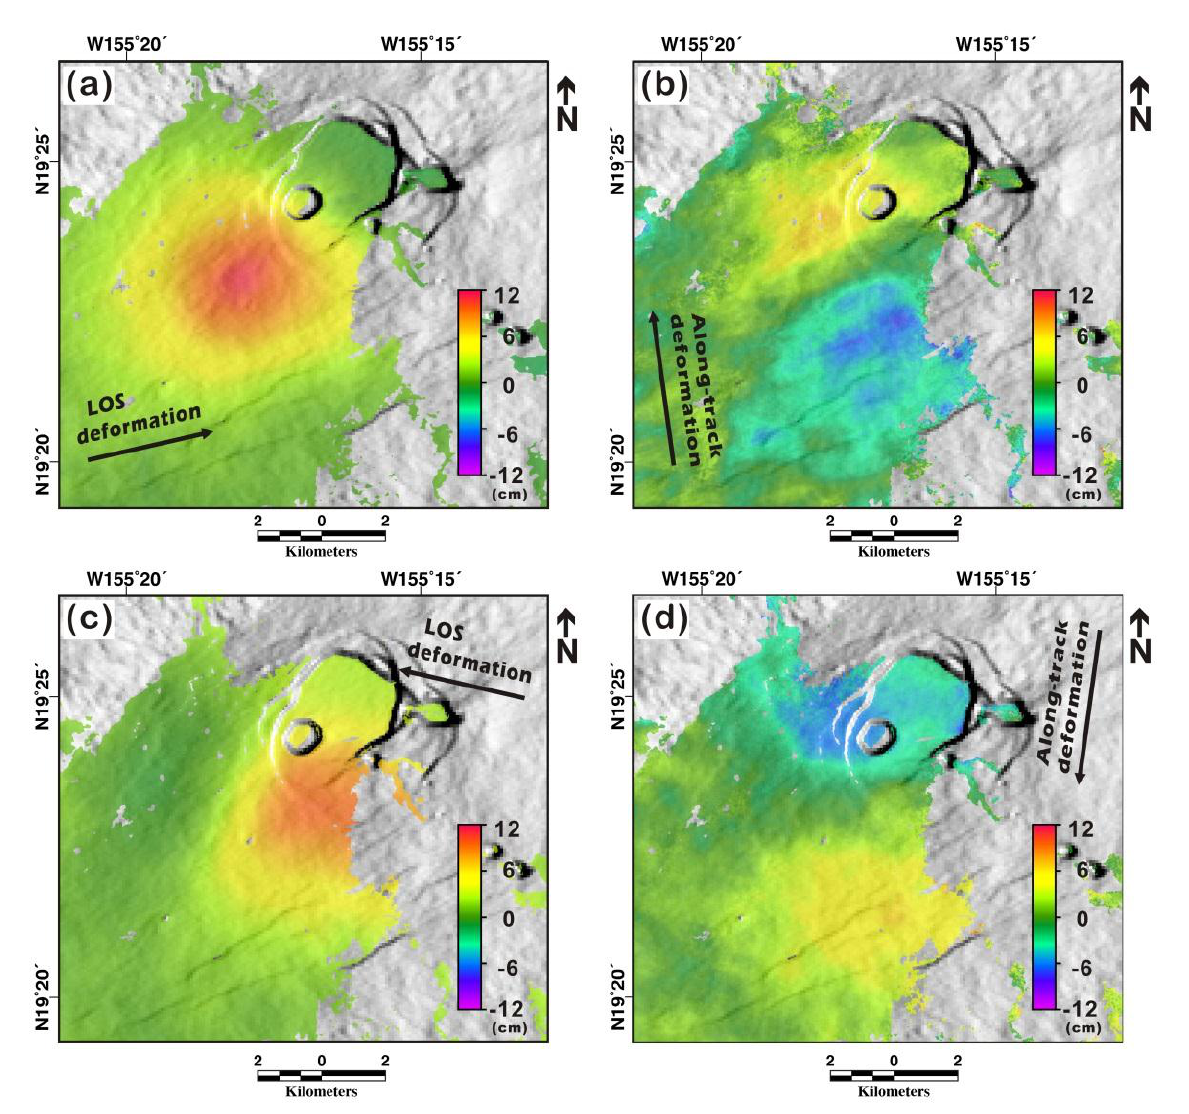
Figure 2. Multi-stacked InSAR and MAI measurements. ( a ) LOS and ( b ) along-track deformation based on InSAR and MAI measurements from ascending orbits. ( c ) LOS and ( d ) along-track deformation based on InSAR and MAI measurements from descending